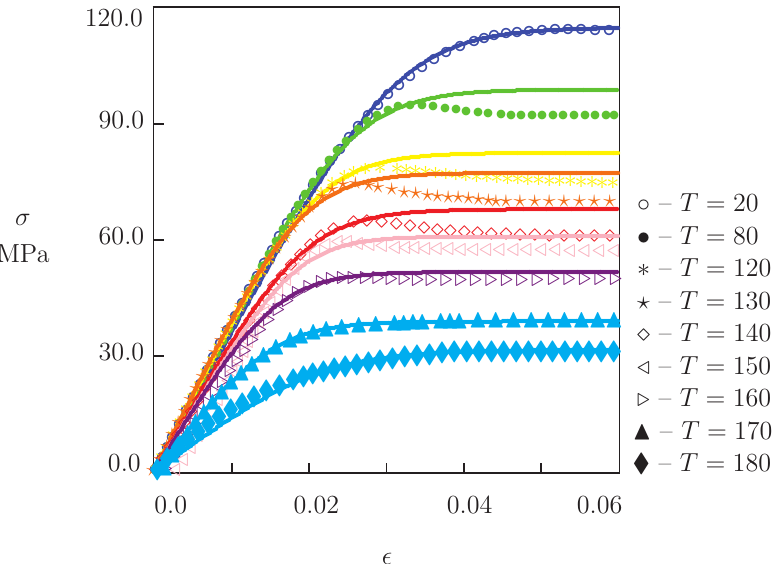
Figure 2. Stress σ versus strain (cid:101) . Symbols: experimental data in tensile tests with strain rate ˙ (cid:101) = 3.1 10 − 3 s − 1 at temperatures T ◦ C. Solid lines: results of simulation. ×